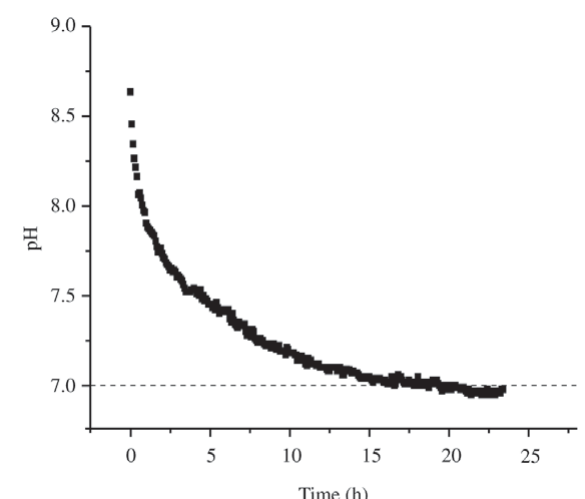
Figure 8. Variation of pH with hydrolysis time. (Cement: fine β -TCP; L/P = 1.0 ml/g; 1.0 M Na